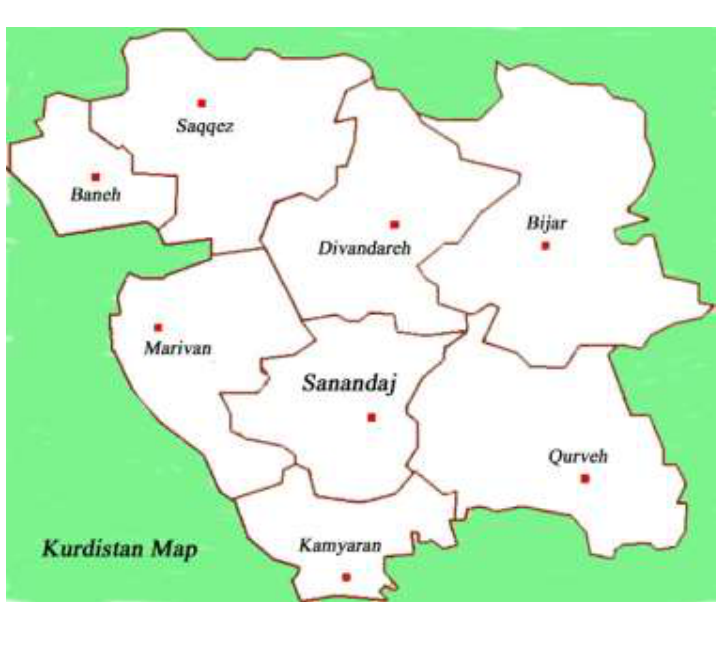
Figure 1. Map of